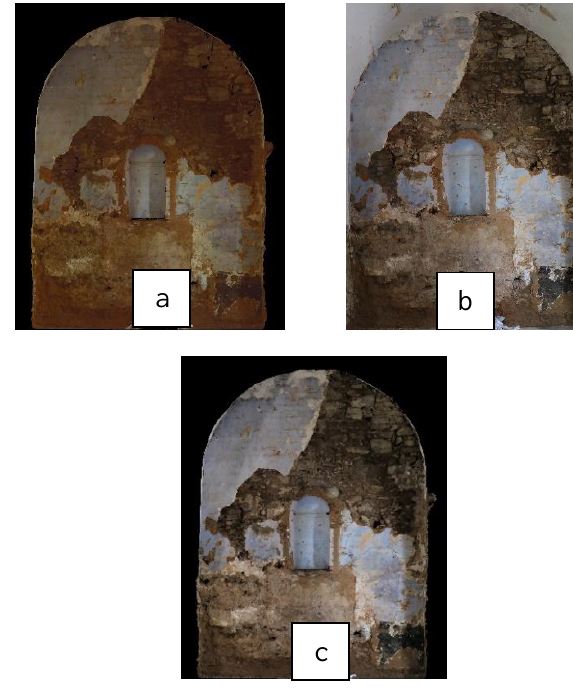
Figure 11 . TLS (a), CRP (b) and TLS+CRP (c) ortophotos